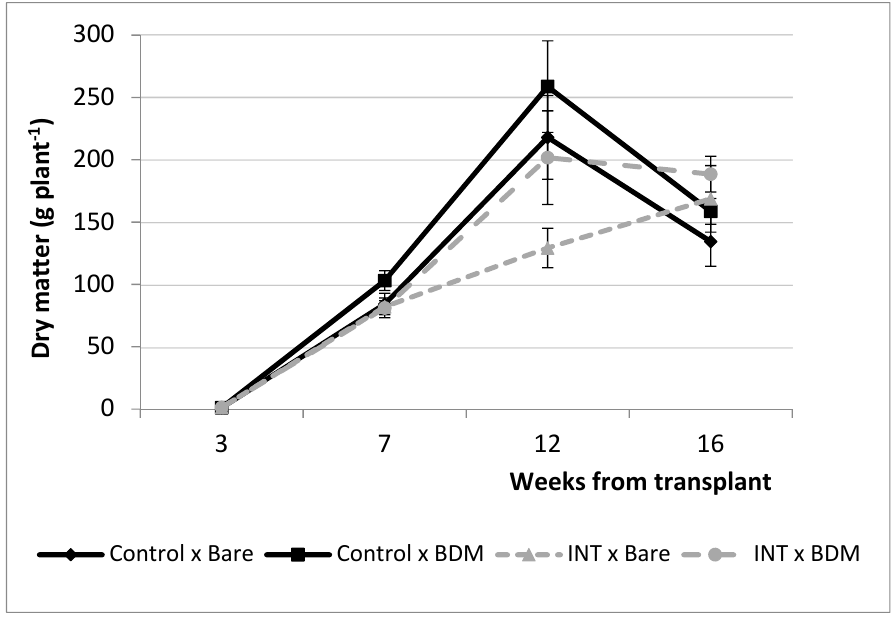
Figure 1. Dry matter accumulation in stems and leaves biomass of tomato cv Heinz 5508 during the 2017 crop cycle.Legend: vertical bars represent error standard of mean (N = 10) per each combination of treatments in different sampling times. Control × Bare: standard farm fertilization × Bare soil; Control × BDM: standard farm fertilization × Biodegradable mulch; INT × Bare: solid digestate integrated with mineral fertilizers × Bare soil; INT × BDM: solid digestate integrated with mineral ferti-